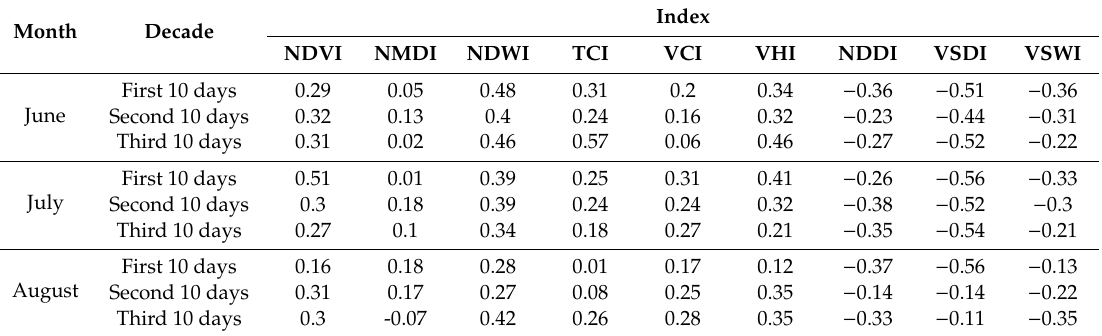
Table 3. Multi-year correlation between 10-day indices and spring wheat yield in June to August (2000–2017).